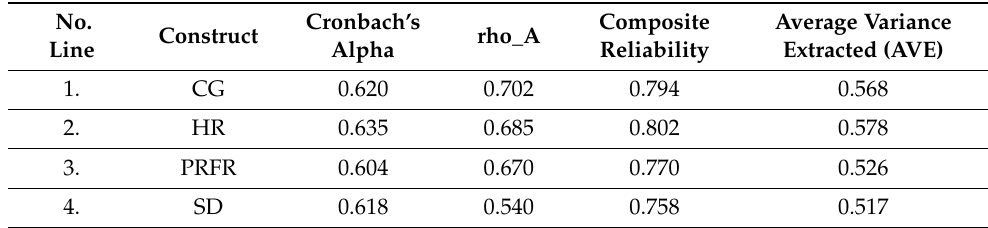
Table 2. Convergent reliability and validity